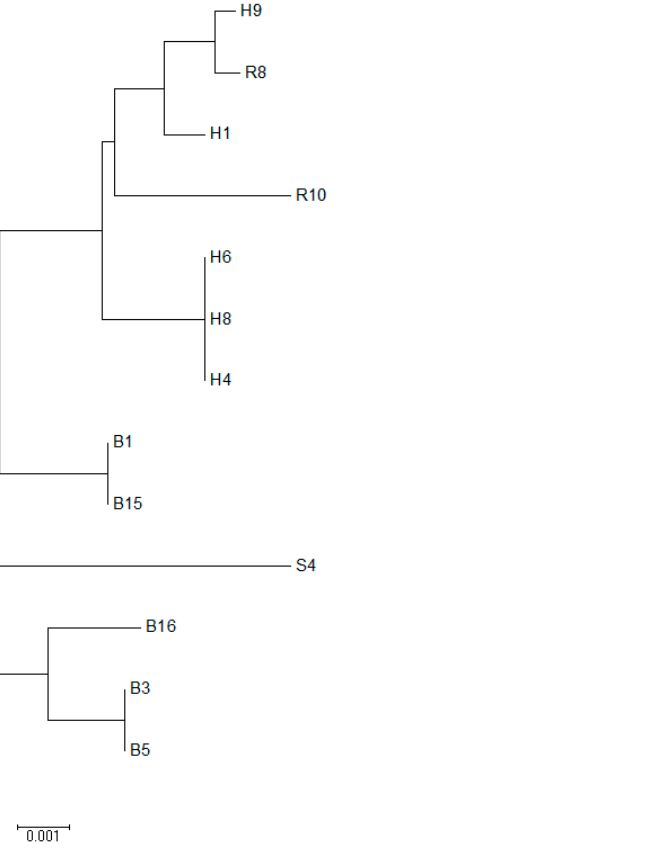
Figure 3. Evolutionary relationships of taxa.